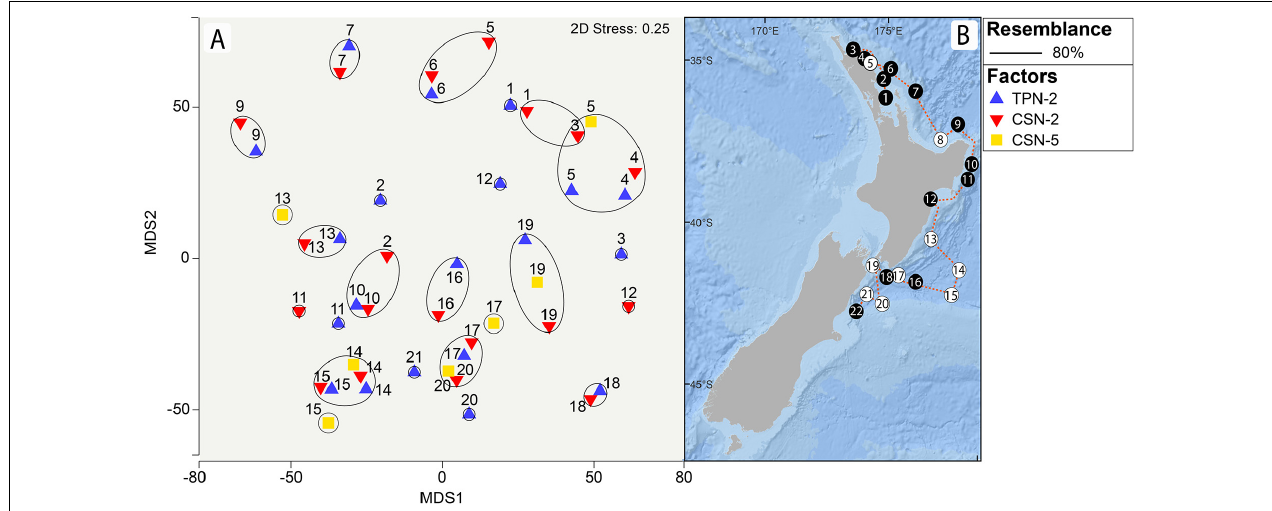
FIGURE 5 | Metric Multi Dimensional Scaling (mMDS) ordination plots based on fourth root transformed data and Bray Curtis similarities obtained from the New Zealand dataset (A) , with the corresponding sampling station numbers (1–22) as described in Table 1 and Figure 2 . (B) Colored symbols correspond to different factors: Traditional Plankton Net at < 3 knots (TPN2), Cruising Speed Net at < 3 knots (CSN2) and at > 3 knots (CSN5). Circles connect samples with at least 80% community resemblance.